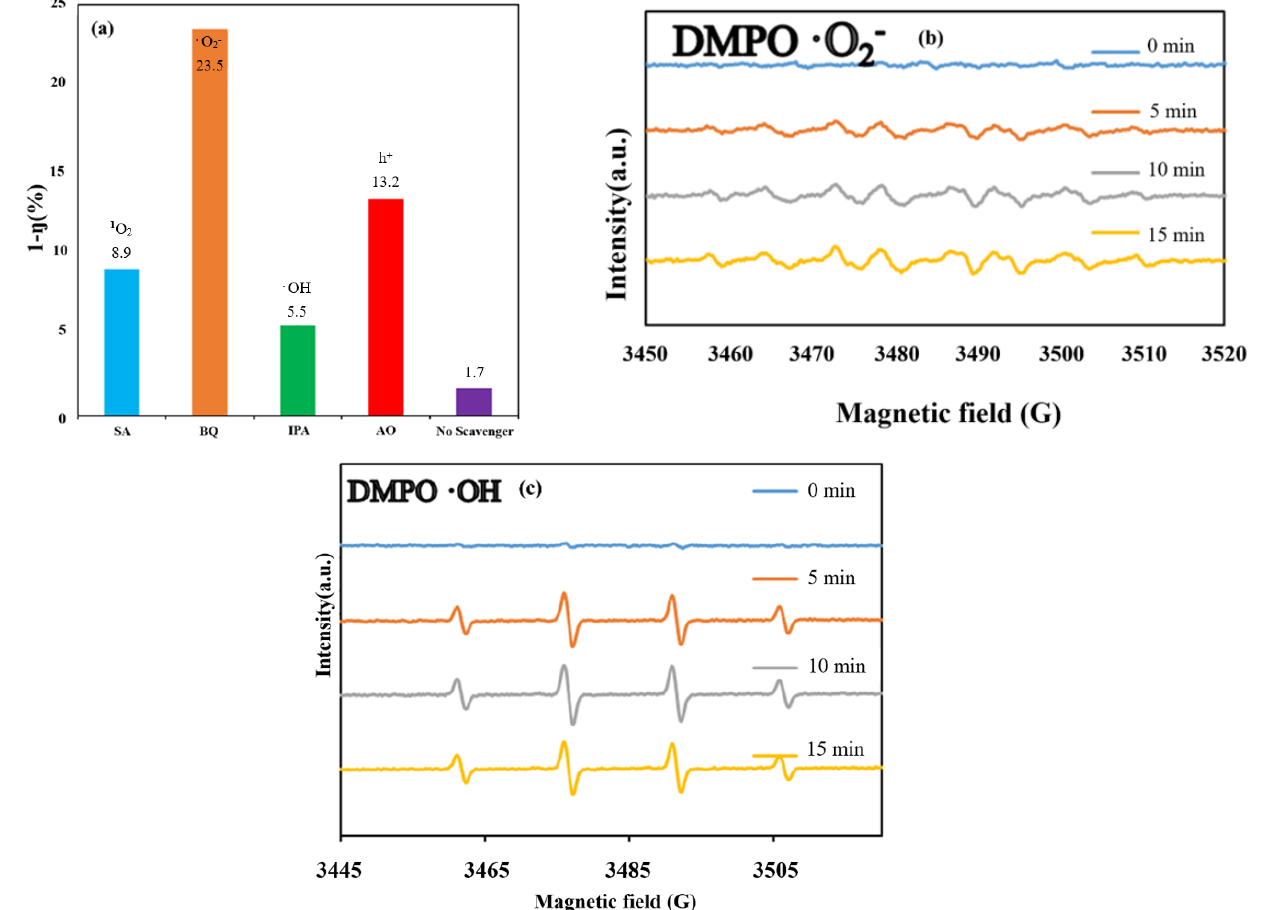
Figure 12. ( a ) Variations in the dye concentration with the irradiation time on the BiOmCln/BiOpIq/g-C3N4-20% photocatalyst prepared under a KCl:KI molar ratio of 1:2, a hydrothermal temperature of 250 °C, and a pH of 4 when using different scavengers (i.e., sodium azide, p-benzoquinone, ammonium oxalate, and isopropanol). Electron paramagnetic resonance spectra for ( b ) DMPO-•O 2 − and ( c ) DMPO-•OH on the aforementioned catalyst under visible-light irradiation.